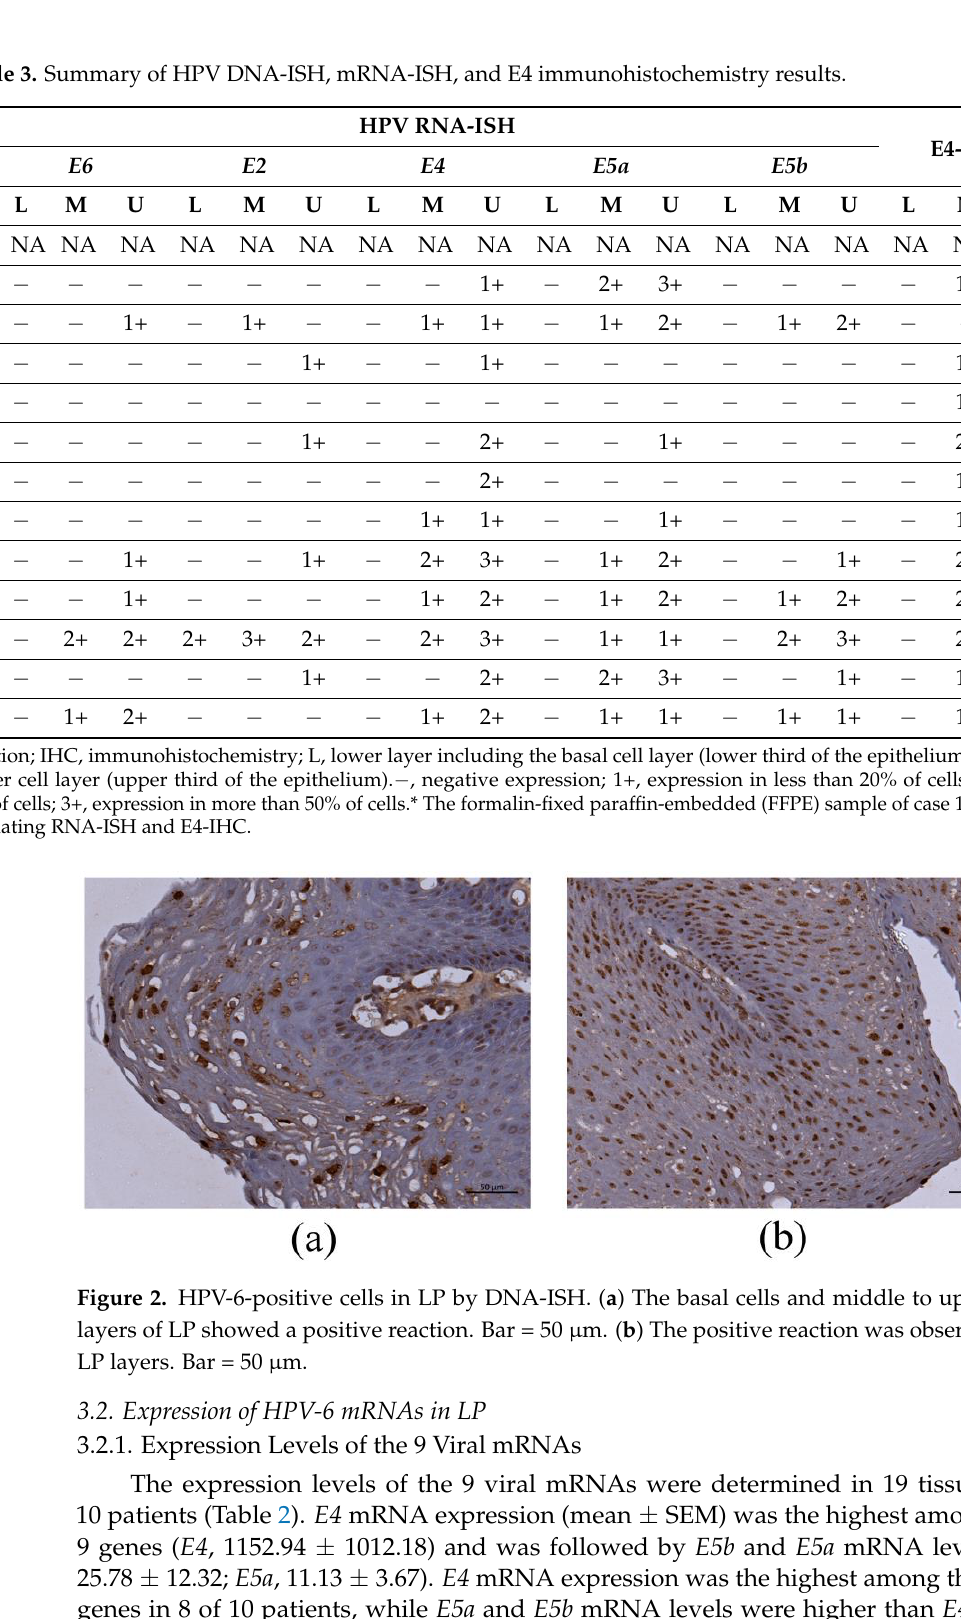
Table 3. Summary of HPV DNA-ISH, mRNA-ISH, and E4 immunohistochemistry results. DNA-ISH Case